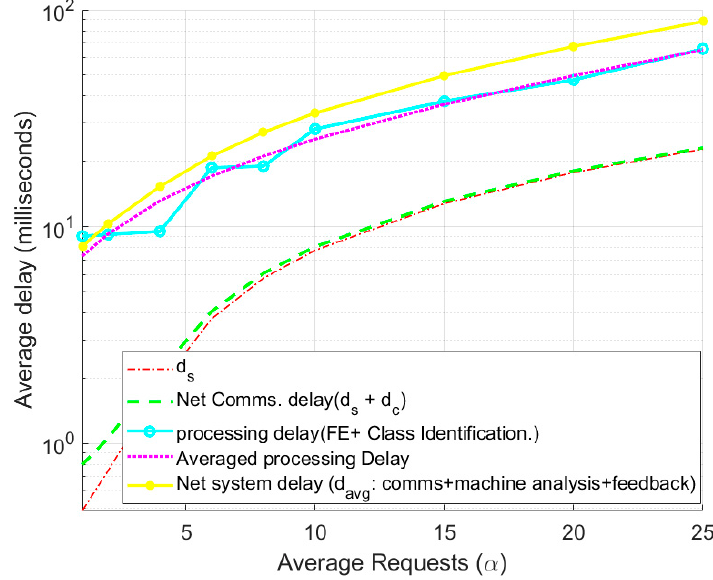
Figure 7. Communications, processing and System delay.